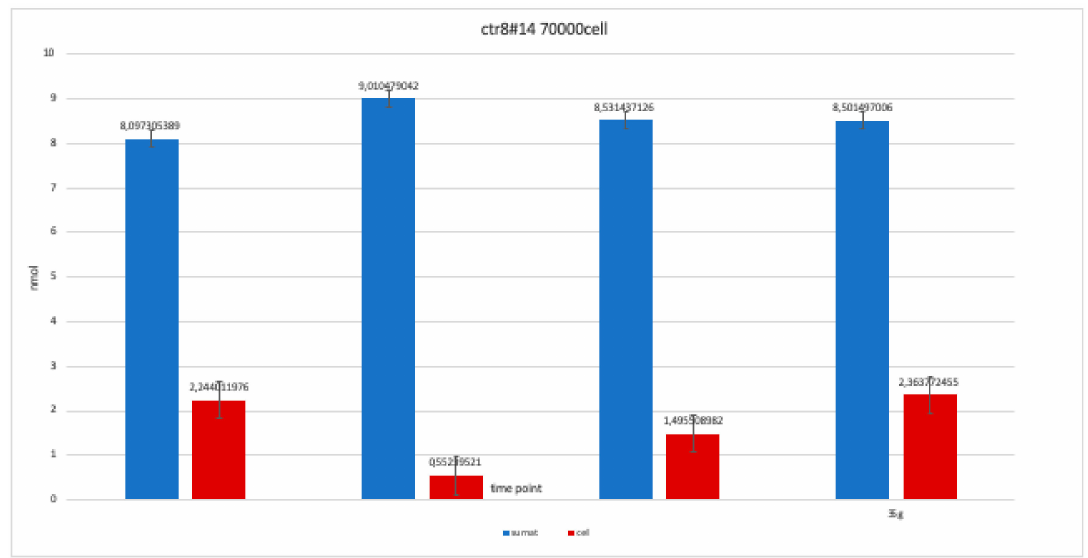
Figure 11. Level of alkaline phosphatase contained in clone CTR8#14 P12 – RA plate on 70,000 cells for the well; the trend is not increasing but rather balanced over time. The clone is the only one to have an alkaline phosphatase of 35 days because it was the clone for which the biological trend developed first, and that produced the largest number of cells, so there wasa greater availability of wells of the plate to carry out tests.